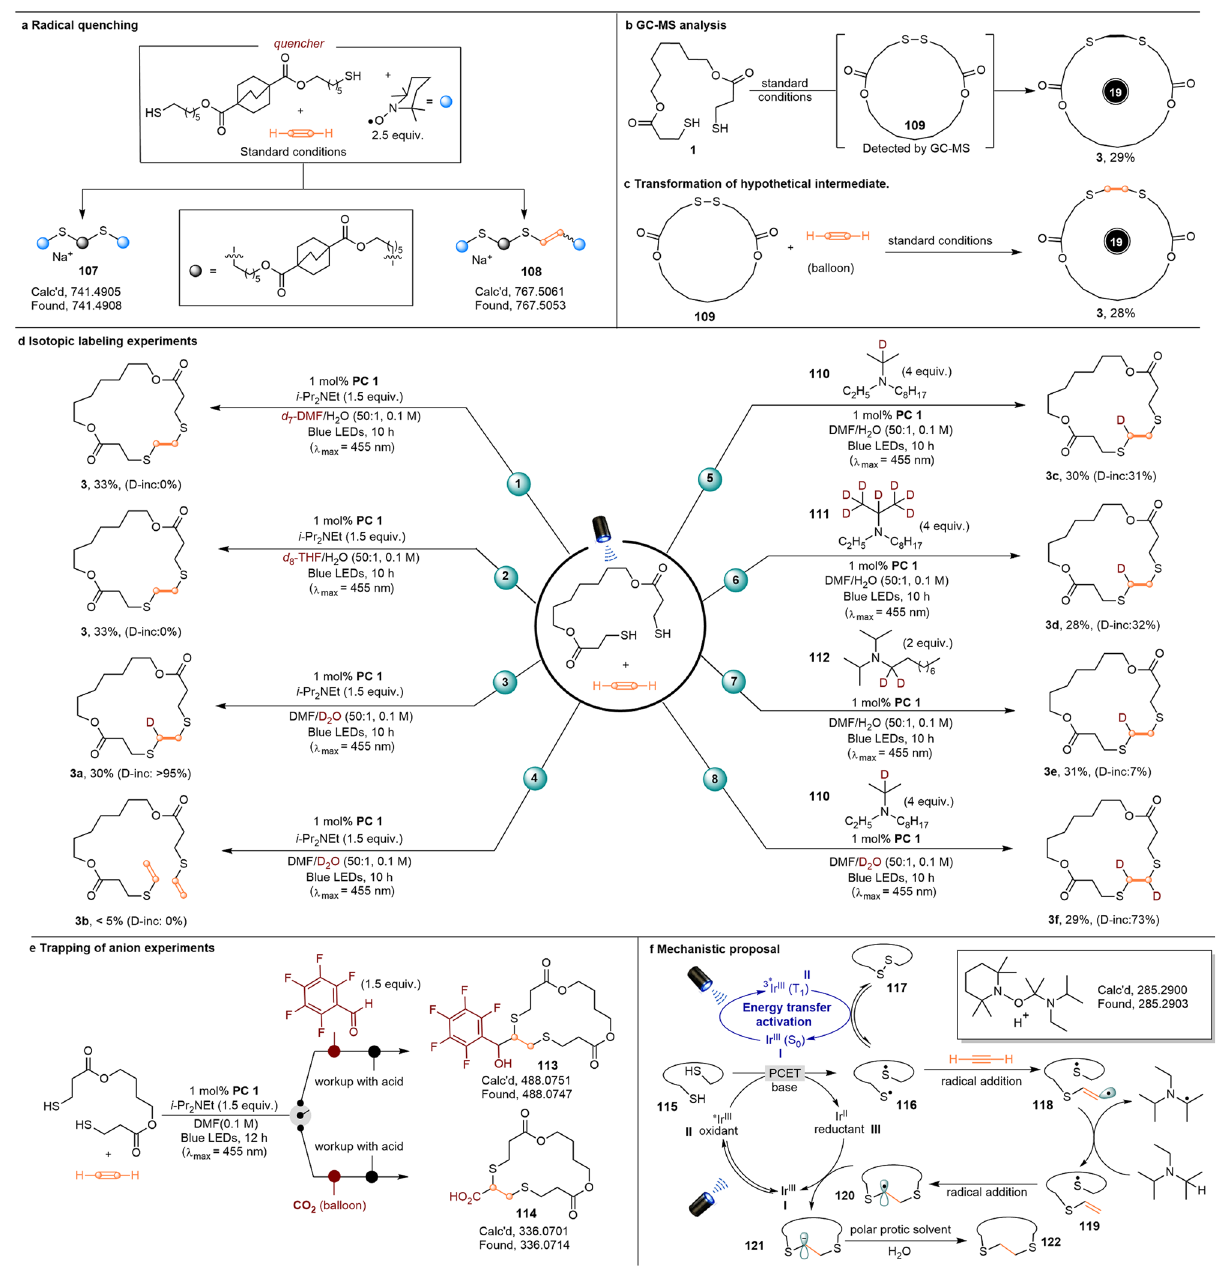
Fig.6|Mechanisticstudies.a Radicaltrappingexperiment. b GC-MSanalysis. c Transformationofhypotheticalintermediate. d Isotopiclabelingexperiments. e Trapping of carbanion intermediate. f Proposed reaction